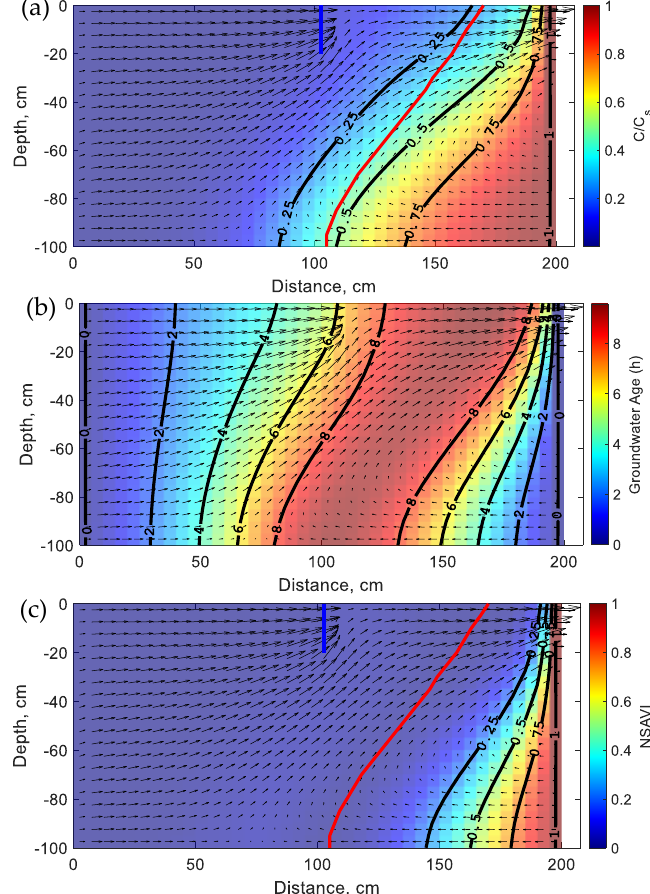
Figure 3. Spatial distribution patterns of ( a ) the steady-state concentration isochlors, ( b ) the direct mean groundwater age, and ( c ) the vulnerability index to seawater intrusion for the modified Henry problem with a partially penetrating pumping well (blue line) discharging 4 × 10 − 5 m 3 · s − 1 . The zero-vulnerability line (ZVL) is plotted with red